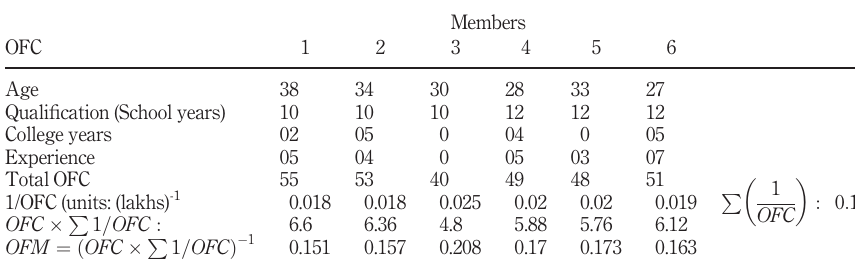
OFM (Objective Factor Measure) for each member is obtained as Table 7.